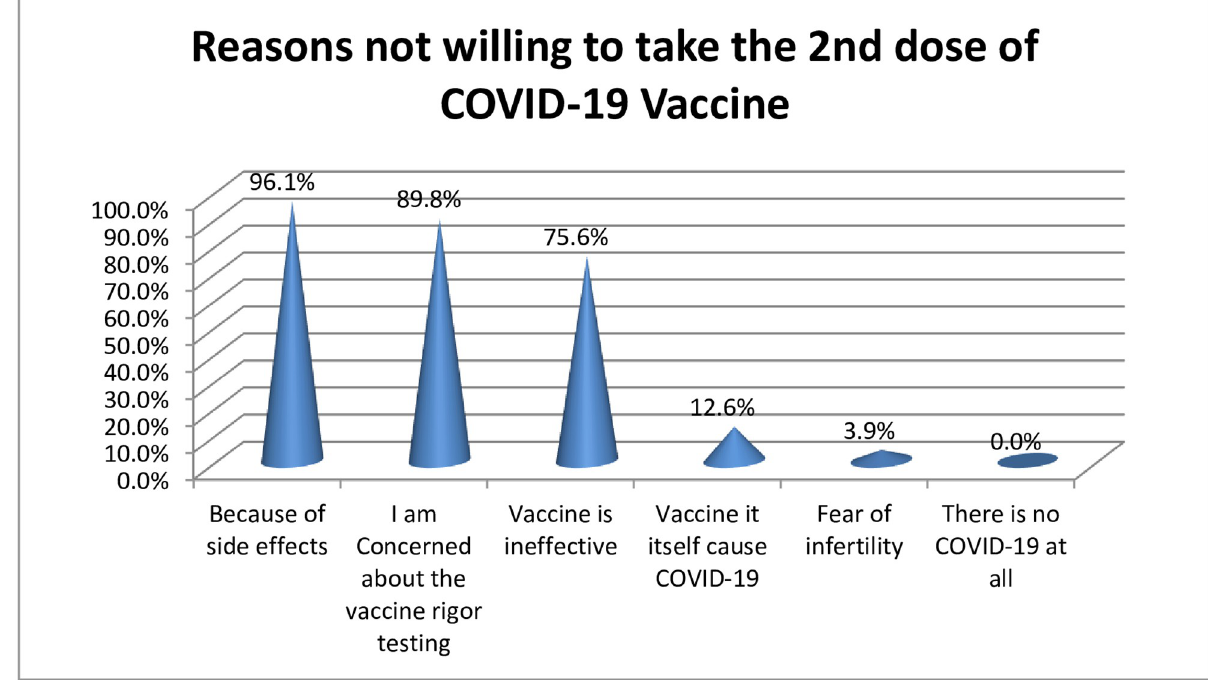
Fig 2. Reasons not willing to take the 2nd dose of COVID-19 vaccine among health professionals for the study of post COVID-19 vaccine complication evaluations in central Oromia region, Ethiopia, 2021.